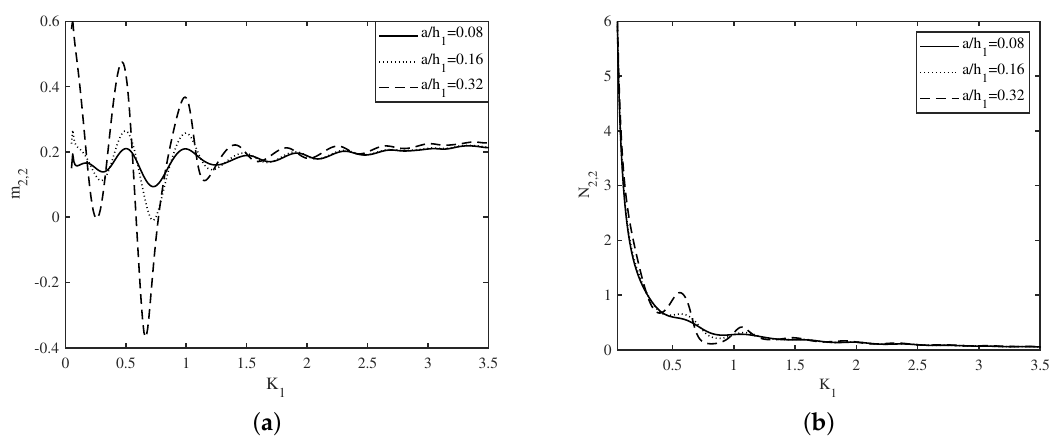
Figure 6. Variation of ( a ) m 2,2 and ( b ) N 2,2 vs K 1 for different a / h 1 .